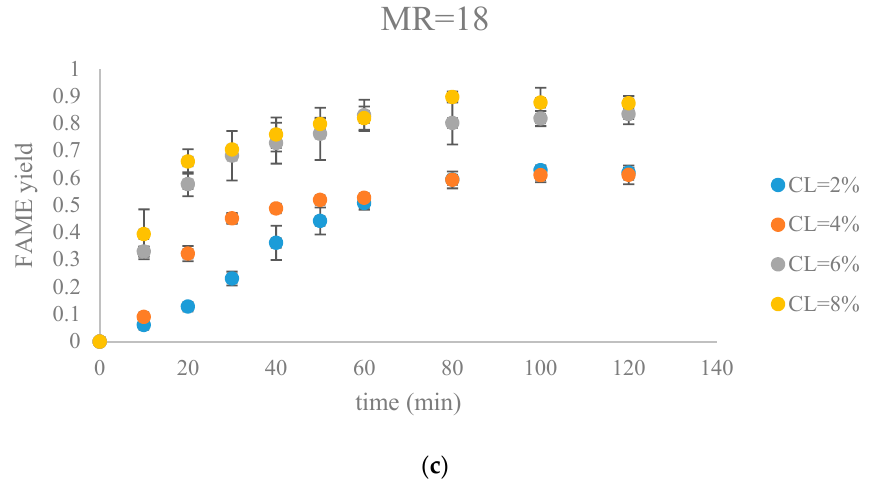
Figure 7. The fatty acid methyl ester (FAME) yield with the progress of the soybean oil transesterification catalyzed by Na-COS grouped by molar ratio of methanol to oil (MR) ( a ) MR = 6; ( b ) MR = 12; ( c ) MR = 18.